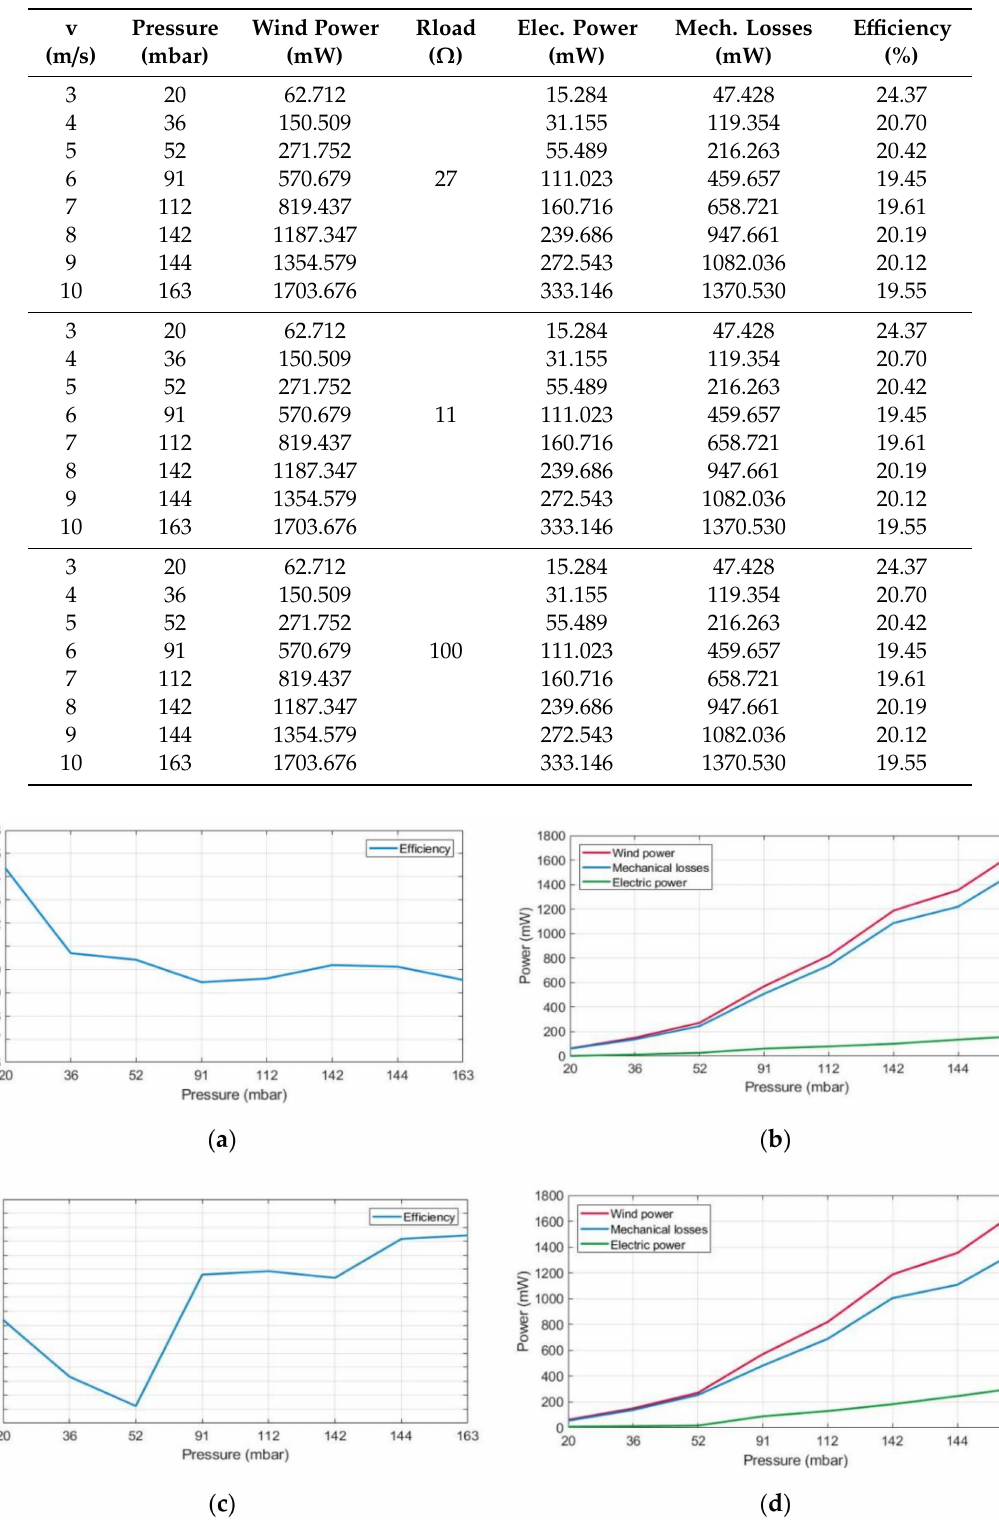
Table 10. Generated electric power, mechanical losses, and system e ffi ciency values from 3 m / s to 10 m / s; from 20 mbar to 163 mbar with 27, 11 and 100 Ω loads.